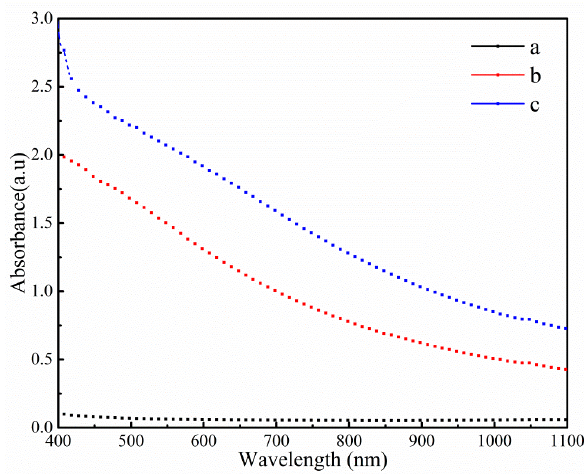
Figure 6. Visible absorbance for different films. ( a ) Control; ( b ) 3% TiO 2 ; and ( c ) 3% TiO 2 –9% CO.